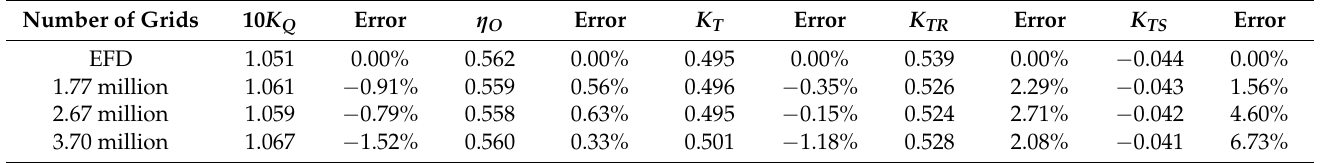
Table 3. Comparison of hydrodynamic performance under different grid numbers.